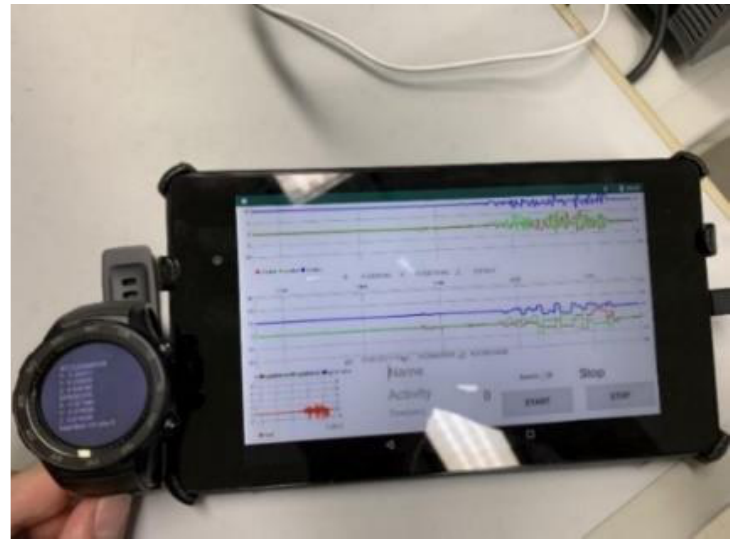
Figure 1. Huawei Watch 2 and tablet. The waveforms transferred from the device are displayed and recorded on the tablet.